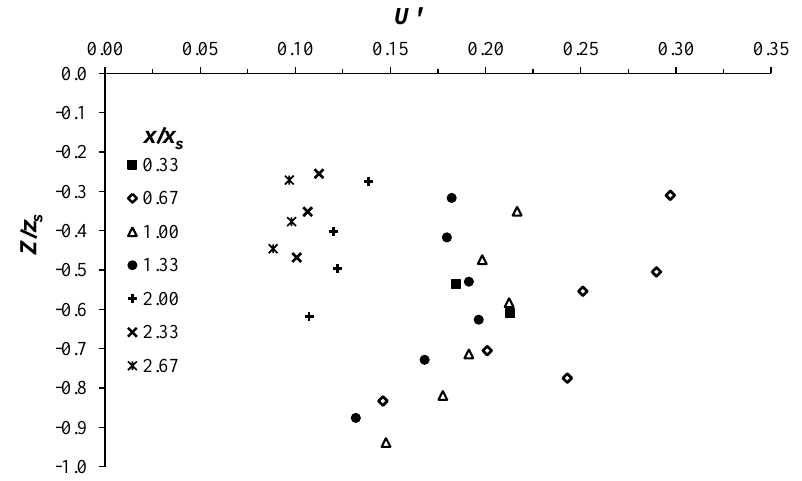
Figure 3. Vertical profiles of streamwise turbulence intensity, U ′ , at different downstream positions x / x s along the plane of flow symmetry ( y = 0).